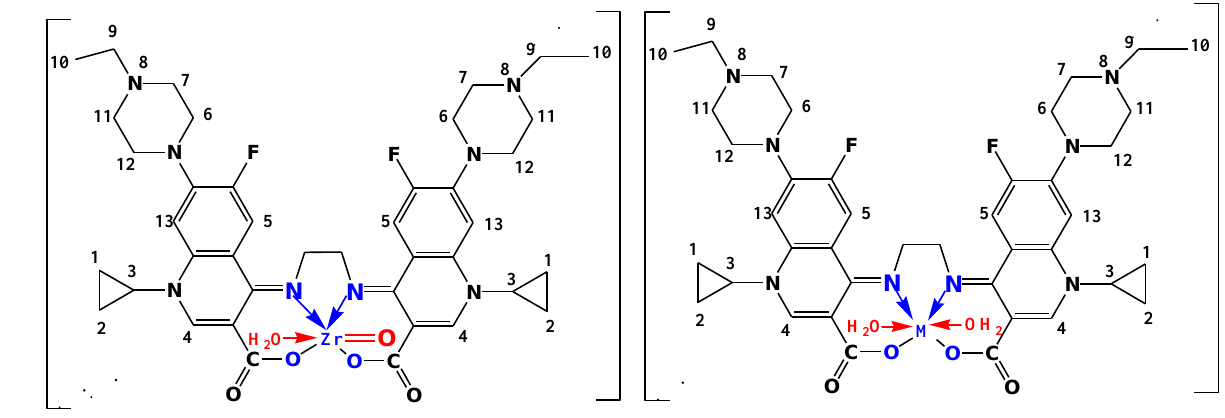
Table 2. Selected infrared wave numbers (cm −1 ) for H 2 Erx-en and its metal complexes.